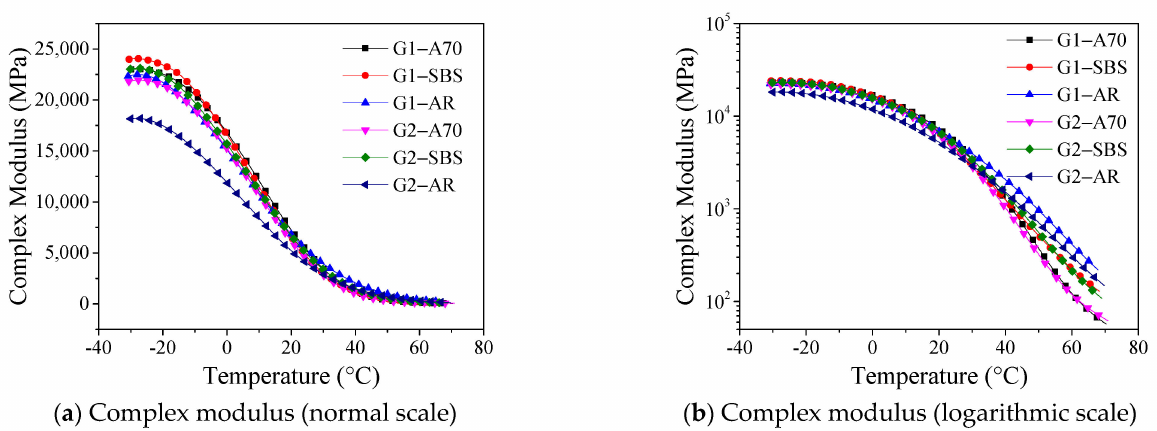
Figure 4. Complex modulus curve (normal and logarithmic